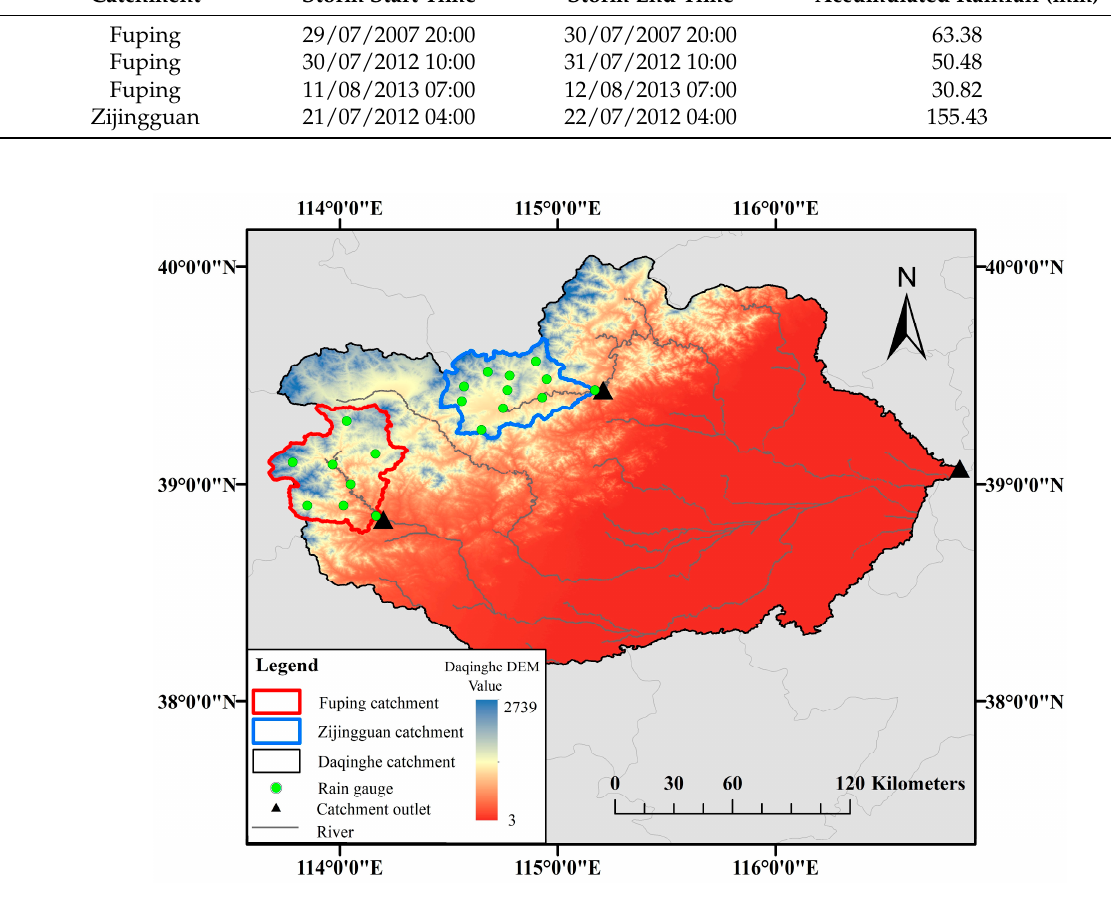
Figure 2. Location map and two study sites in the Daqinghe catchment.